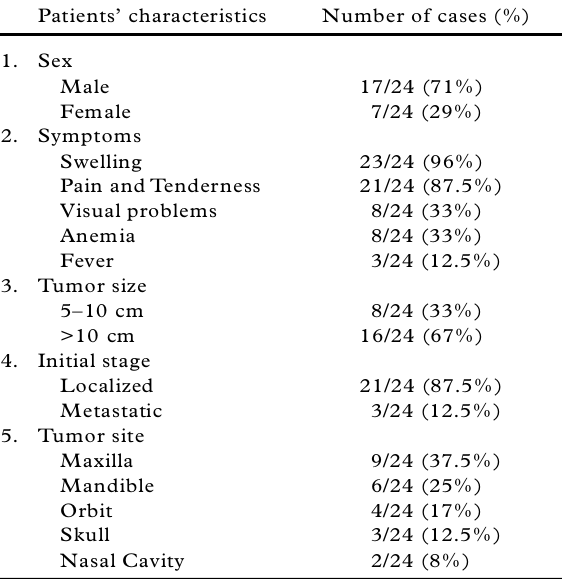
Table 1. Characteristics of evaluable